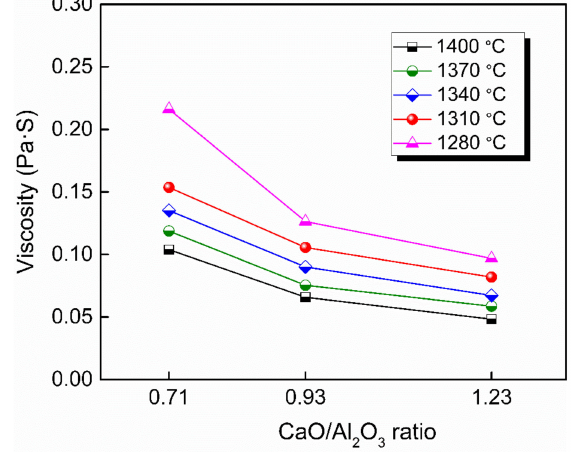
Figure 5. Viscosity of slags S-4 to S-6 in the fully fluid region with various CaO/Al 2 O 3